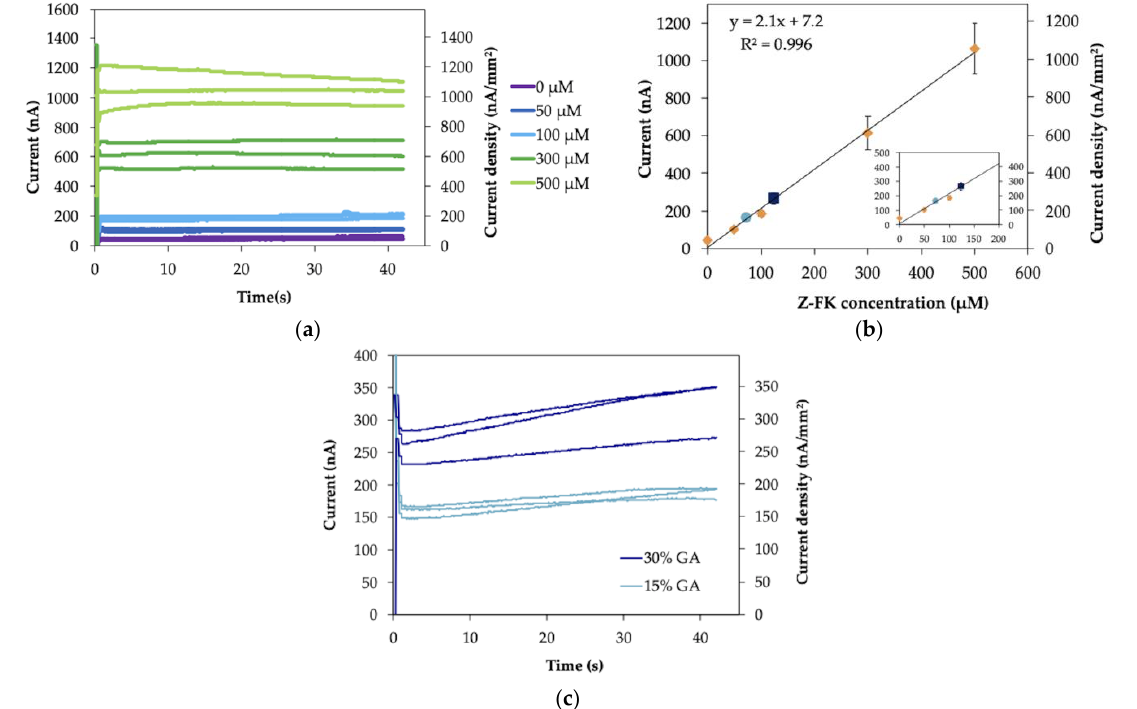
Figure 5. ( a ) Response curve and ( b ) calibration curve of measurement of various concentrations of Z-FK contained in protease-digested nonglycated albumin sample with the IDE enzyme sensor strip in IDE WE - IDE CE mode ( n = 3). ( c ) Response curve of protease-digested glycated albumin (GA) sample measurement with the IDE enzyme sensor strip in IDE WE - IDE CE mode ( n = 3). The current values obtained from protease-digested GA samples were plotted on the cali- bration curve ( b ) as circles (15% GA) and squares (30% GA).